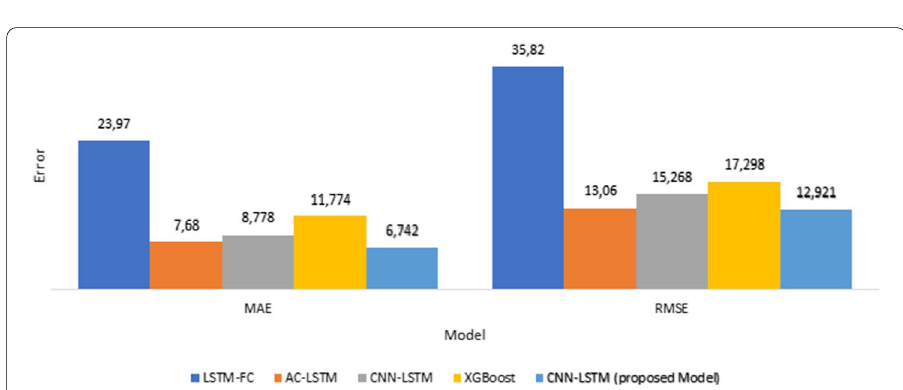
Fig. 17 Comparison of the RMSE and MAE for the proposed model and other